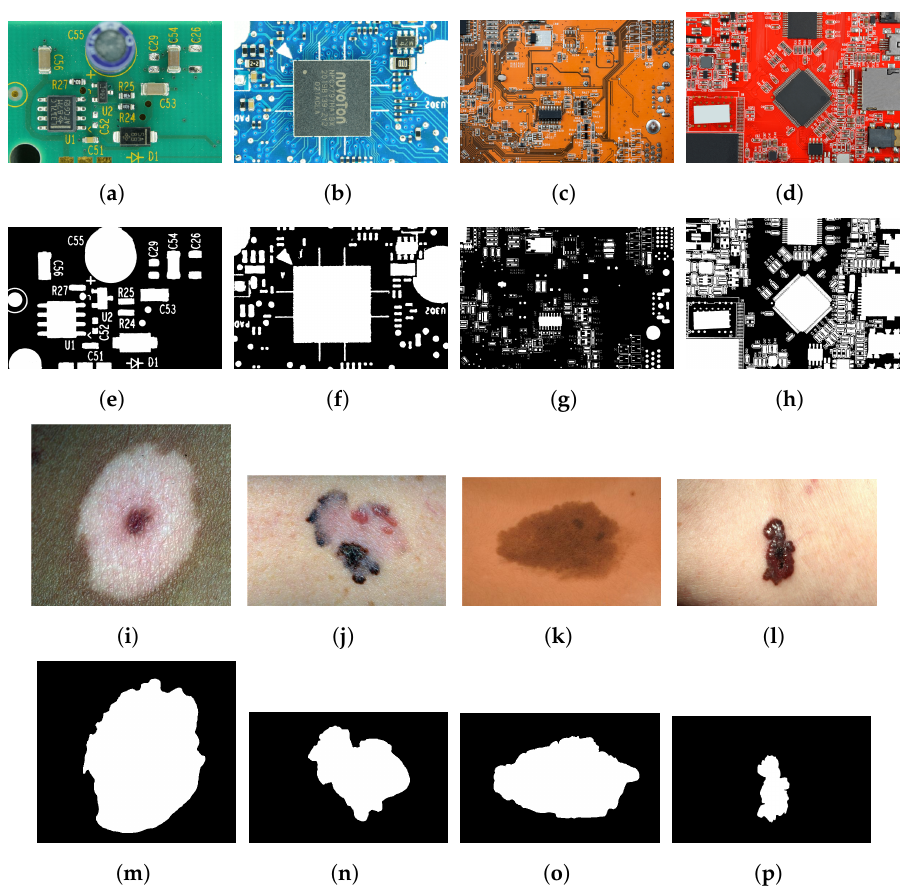
Figure 4. ( a – d ) Sample images of the PCA dataset and ( e – h ) corresponding ground truth. ( i – l ) Sample images of skin cancer dataset and ( m – p ) corresponding ground